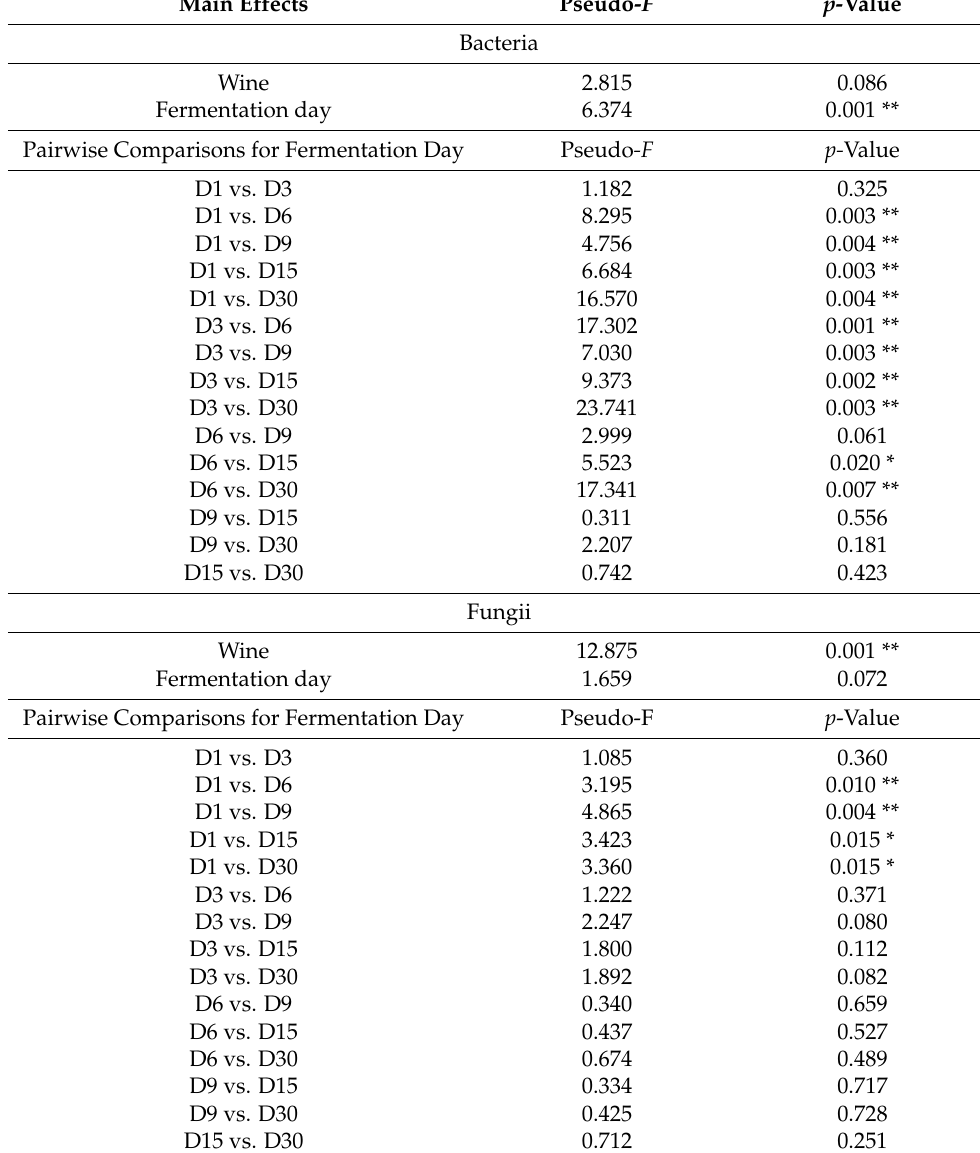
Table 4. Permanova analysis (999 permutations) results for bacteria and fungi communities based on Weighted Unifrac and Bray-Curtis distances, respectively. Abbreviation D: day. Significance levels: * p < 0.05; ** p <